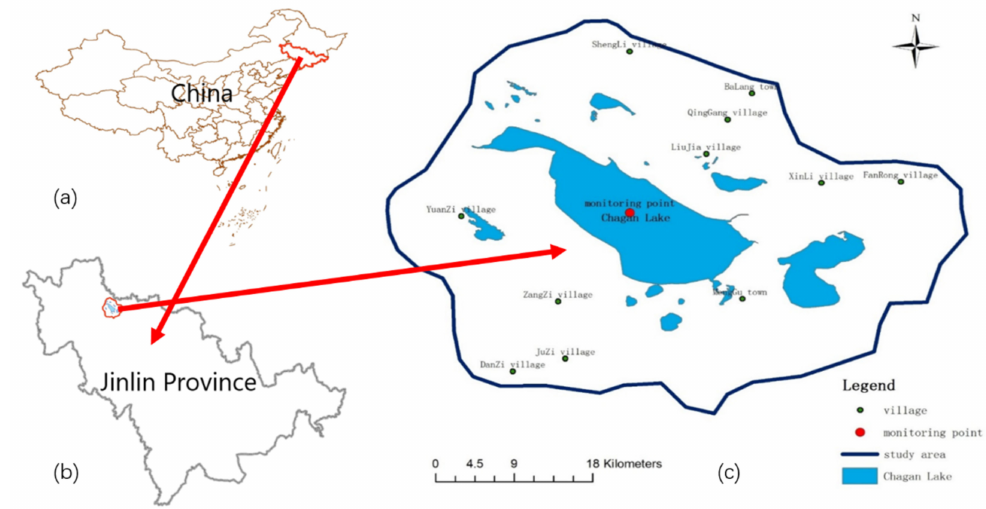
Figure 1. Location of the study area: ( a ) Jilin Province, China; ( b ) the position of the study area in Jilin Province; and ( c ) Chagan Lake wetland ecological environment